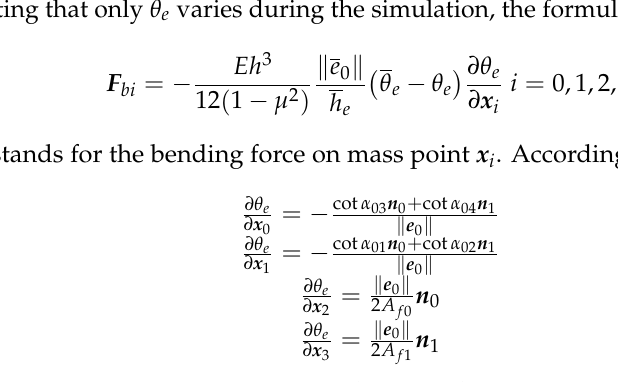
→ x 0 x 1 and x 0 x 3 , α 03 is the angle between → x 1 x 3 , A f and 0 stands for the area of unit symbols are the same as mentioned